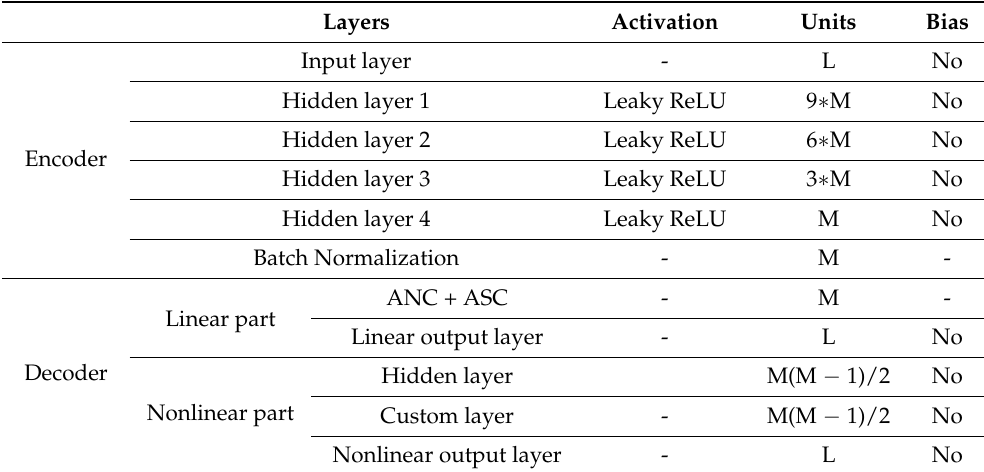
Table 1. Structure of the Proposed Autoencoder Network for GBM. Layers Activation